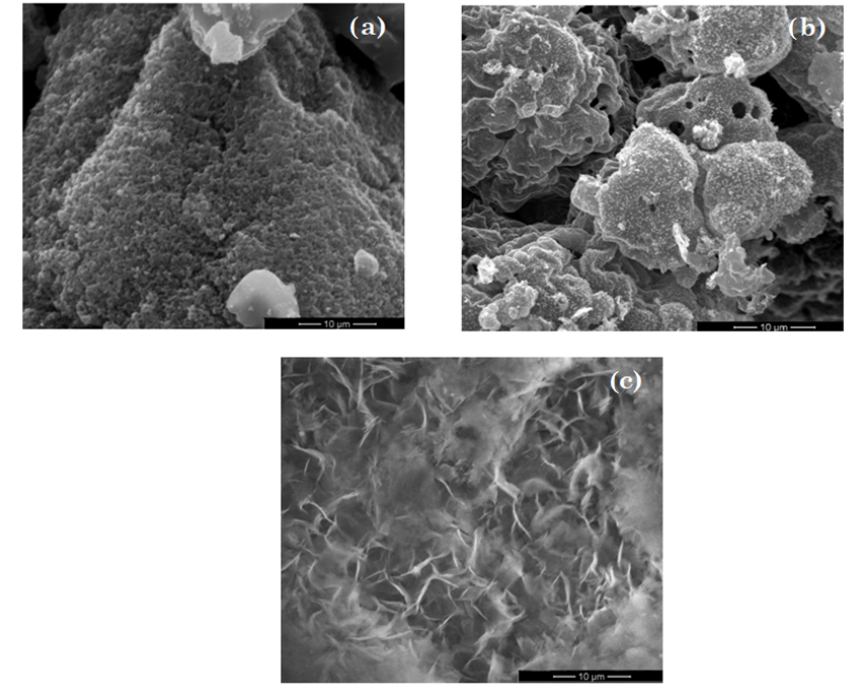
Figure 5. SEM images of TiO 2 ( a ), ZnO ( b ) and MgO ( c ).